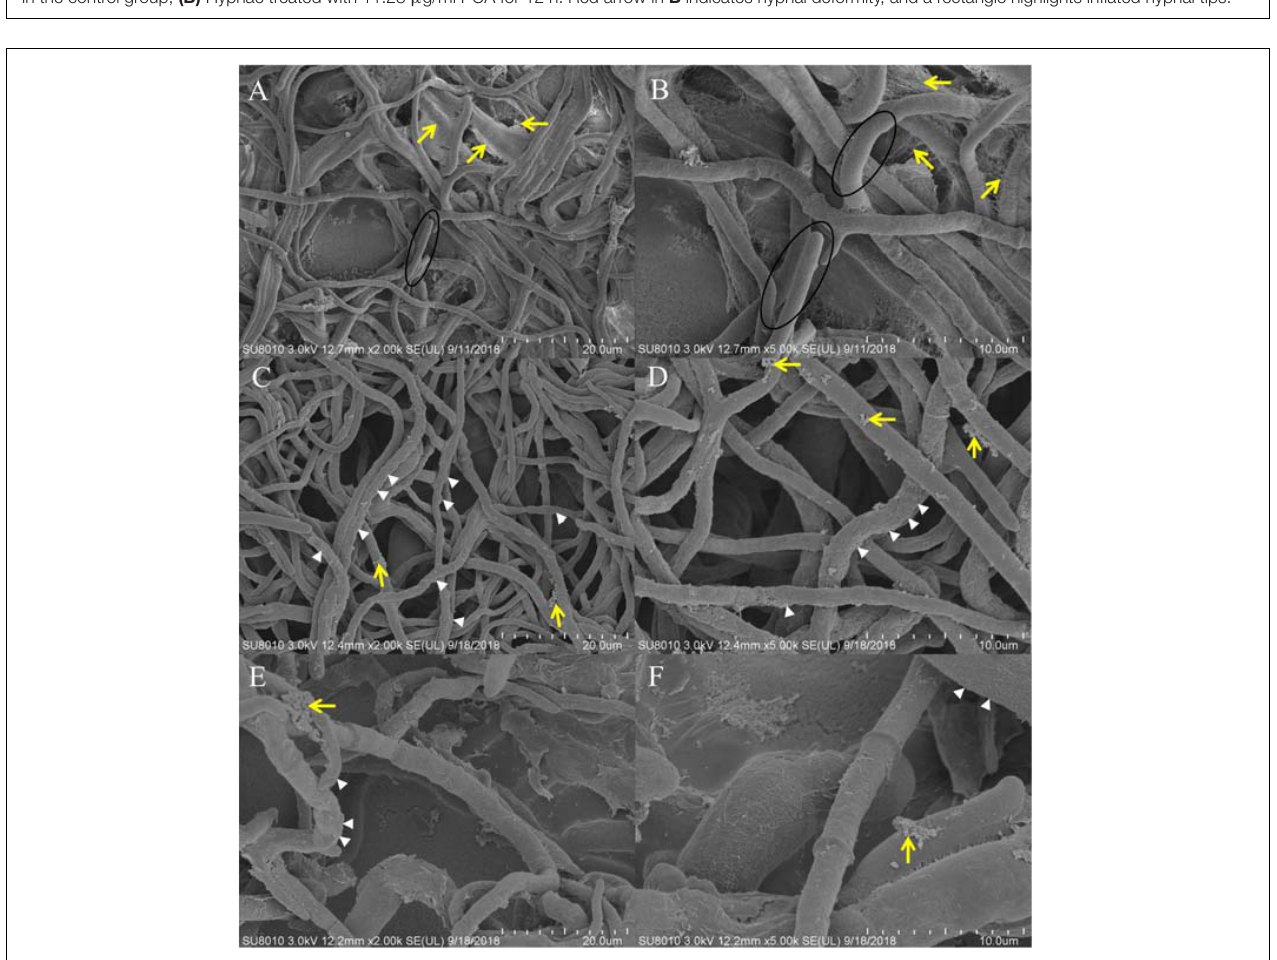
FIGURE 3 | Scanning electron microscopy (SEM) observation of Ps. camelliae-sinensis strain GZHS-2017-010 treated with phenazine-1-carboxylic acid (PCA). (A,B) Control hyphae; (C,D) PCA-treated hyphae at the concentration of 6.38 µ g/ml for 120 h; and (E,F) PCA-treated hyphae at the concentration of 11.23 µ g/ml for 120 h. The magnification levels are shown on each image. The circle in A,B indicates normal plump hyphae, of uniform diameter, with the yellow arrows indicating accumulation of exopolysaccharides (EPS). The white arrows in C–F indicates the rough hyphal surface and inflated tips of the hyphae, whereas the yellow arrows indicate reduced accumulation of